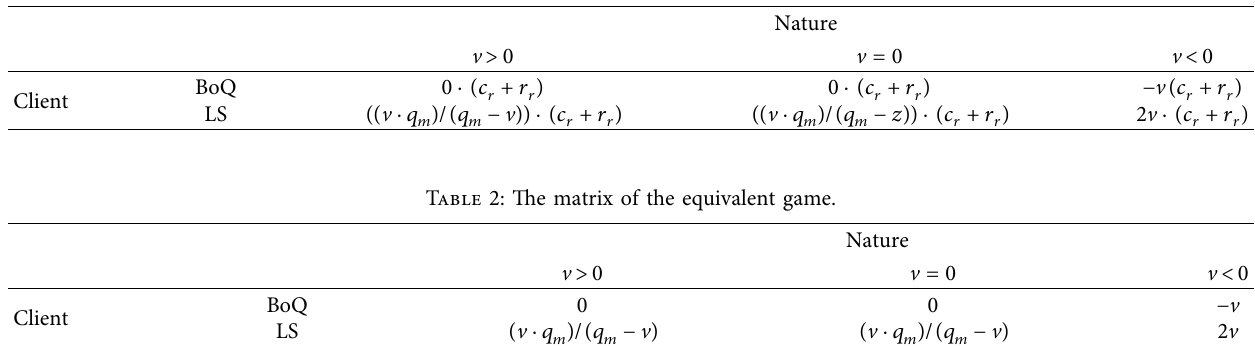
Figure 1: Extensive description of the game. Table 1: The matrix of the simplified game.